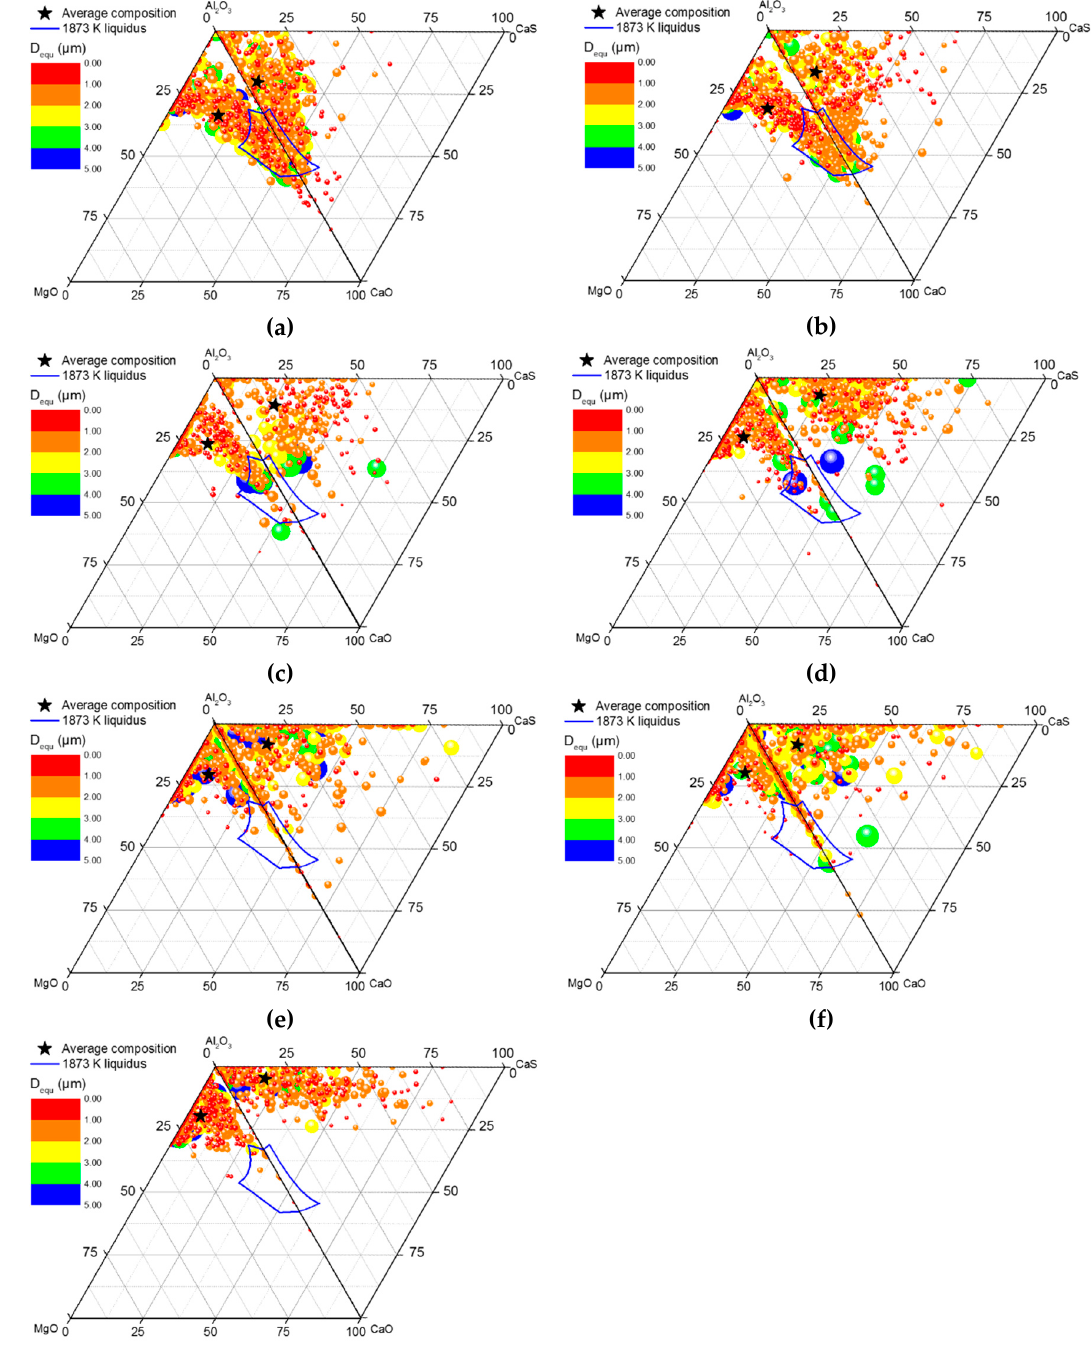
Figure 3. Composition and size of inclusions in steel samples: ( a ) Before and after heat treatment at 1498 K for ( b ) 5 min, ( c ) 20 min, ( d ) 1 h, ( e ) 3 h, ( f ) 7 h, ( g ) 12 h.